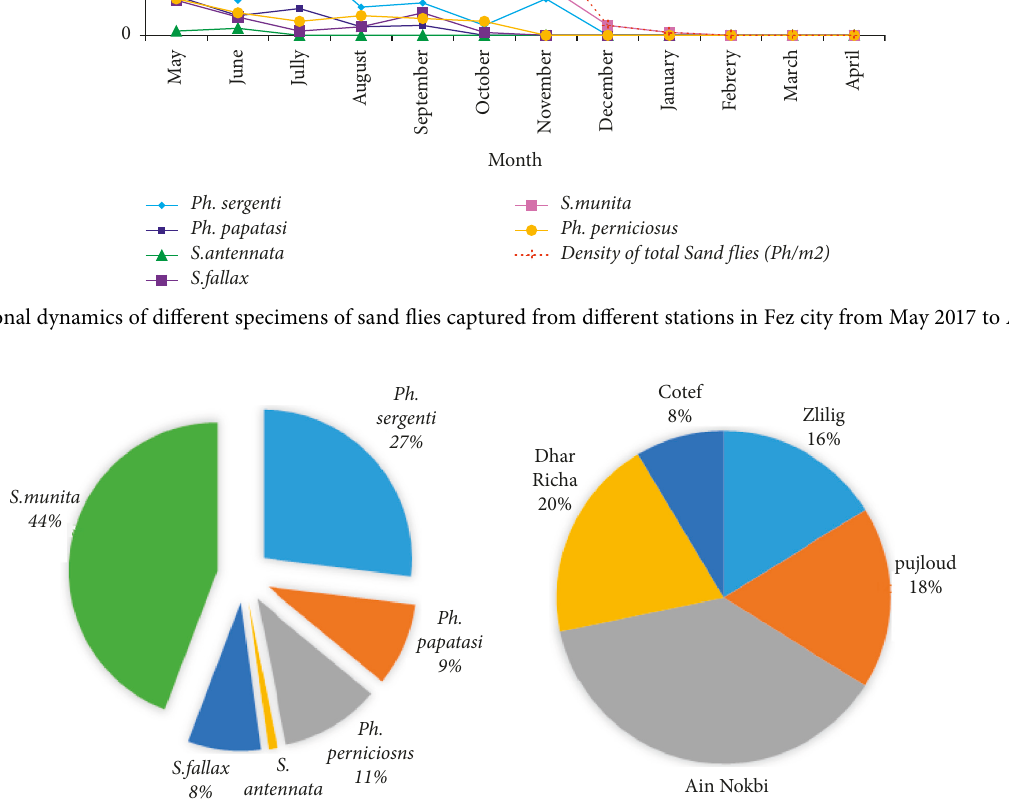
Figure 3: Relative abundance of sand fly species collected in the five stations of the city of Fez from May 2016 to April